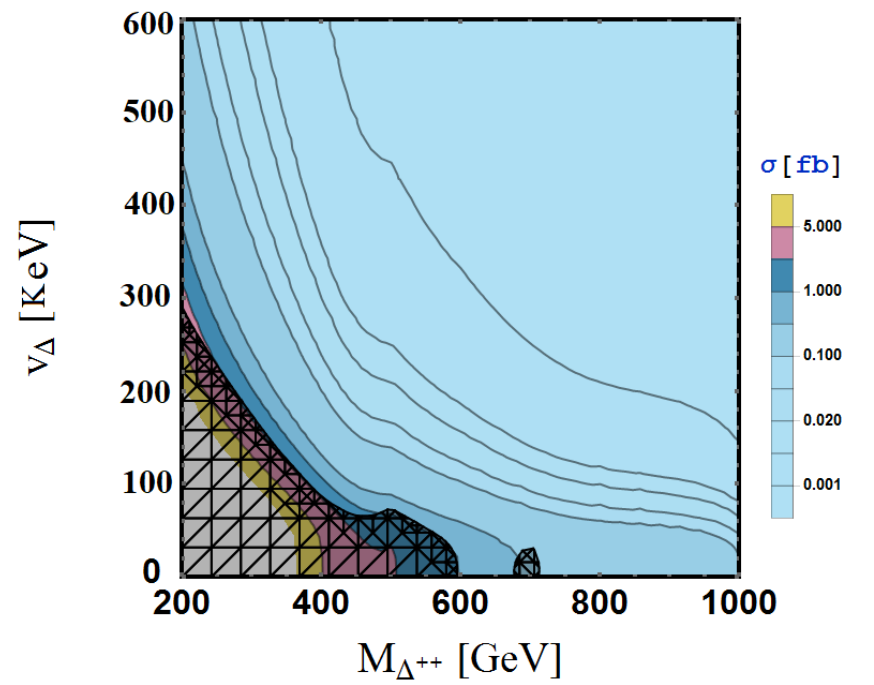
Figure 14 . Contour plot of (cid:27) ((cid:1) ++ (cid:1) (cid:0)(cid:0) ) (cid:2) Br ((cid:1) (cid:6) ! e (cid:6) e (cid:6) ) on v (cid:1) - M region of the plot is excluded from the ATLAS search [1] for same sign dilepton invariant mass peak at 13 TeV center of mass energy and 13.9 fb (cid:0) 1 integrated